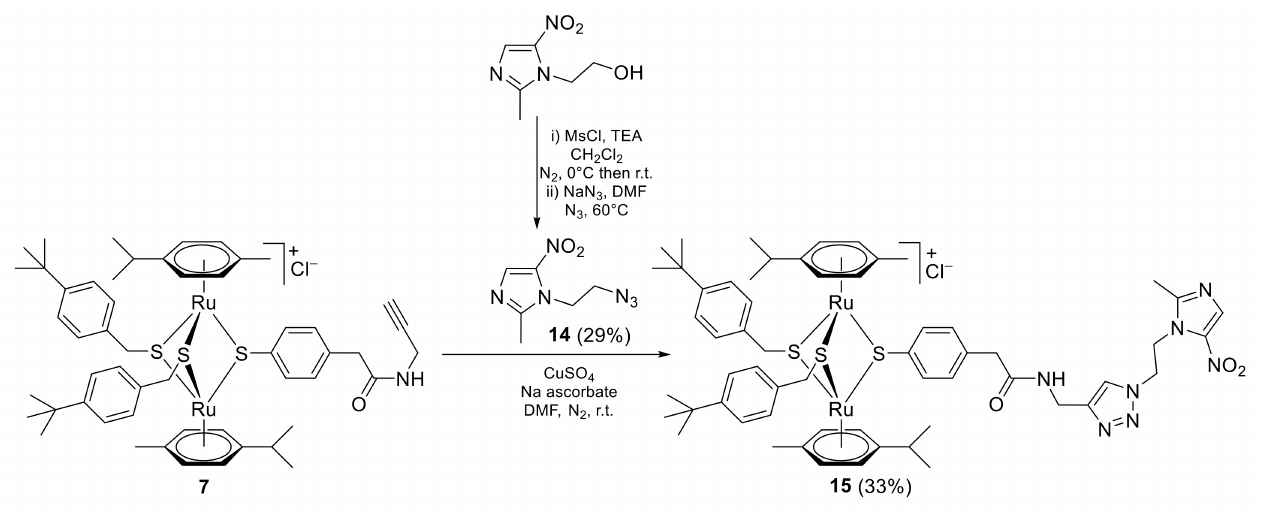
Scheme 4. Synthesis of metronidazole ‘click’ conjugate 15